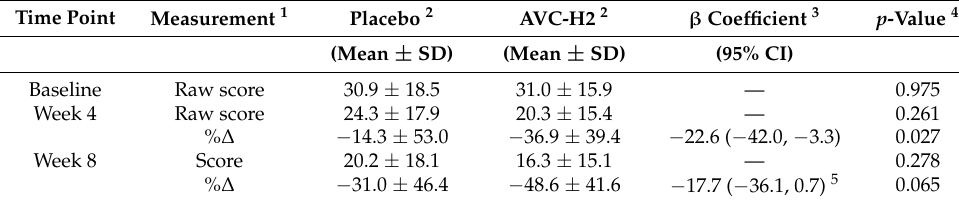
Table 2. WOMAC overall scores from the baseline to the follow-up weeks.